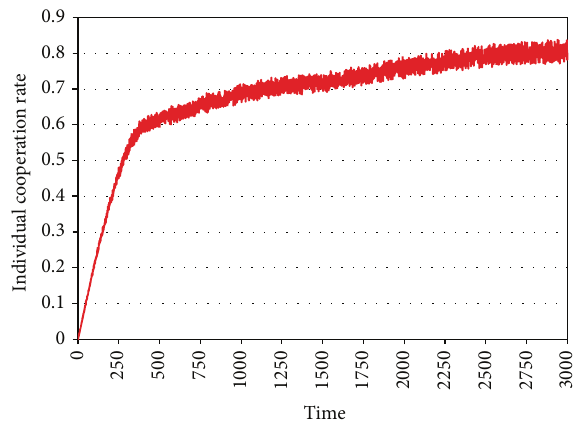
Figure 6: Individual cooperation rate of the proposed complex network.